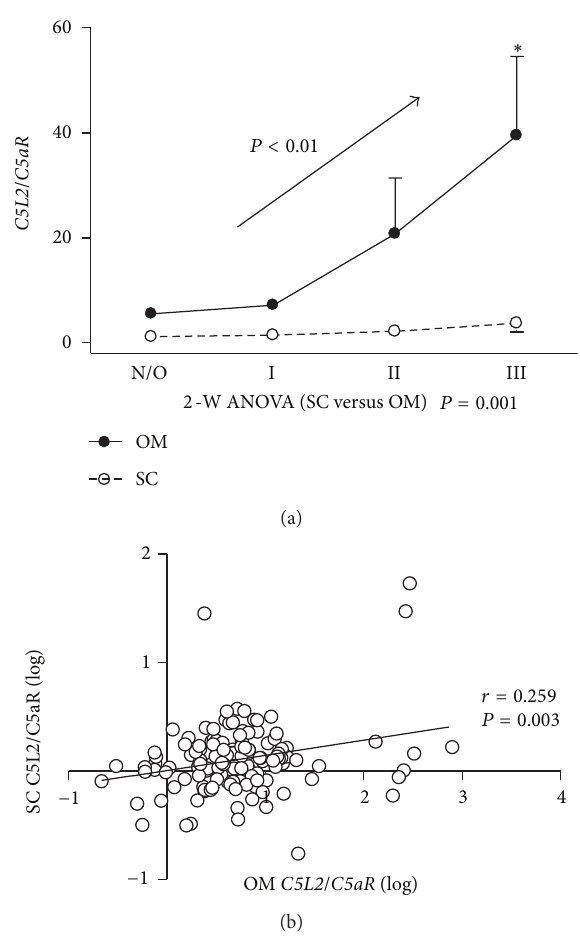
Figure 3: Omental C5L2/C5aR ratio in relation to obesity. (a) C5L2/C5aR ratio in omental adipose tissue (solid circles) versus subcutaneous adipose tissue (open circles), (b) linear regression analysis of subcutaneous versus omental C5L2/C5aR ratio (log- log values). Reported 𝑟 and 𝑃 values were calculated by Pearson correlation. Data are expressed as mean ± SEM and were compared by Student’s 𝑡 -test and one-way ANOVA (versus normal/overweight group), as well as two-way ANOVA (subcutaneous versus omental) where ∗ 𝑃 < 0.05